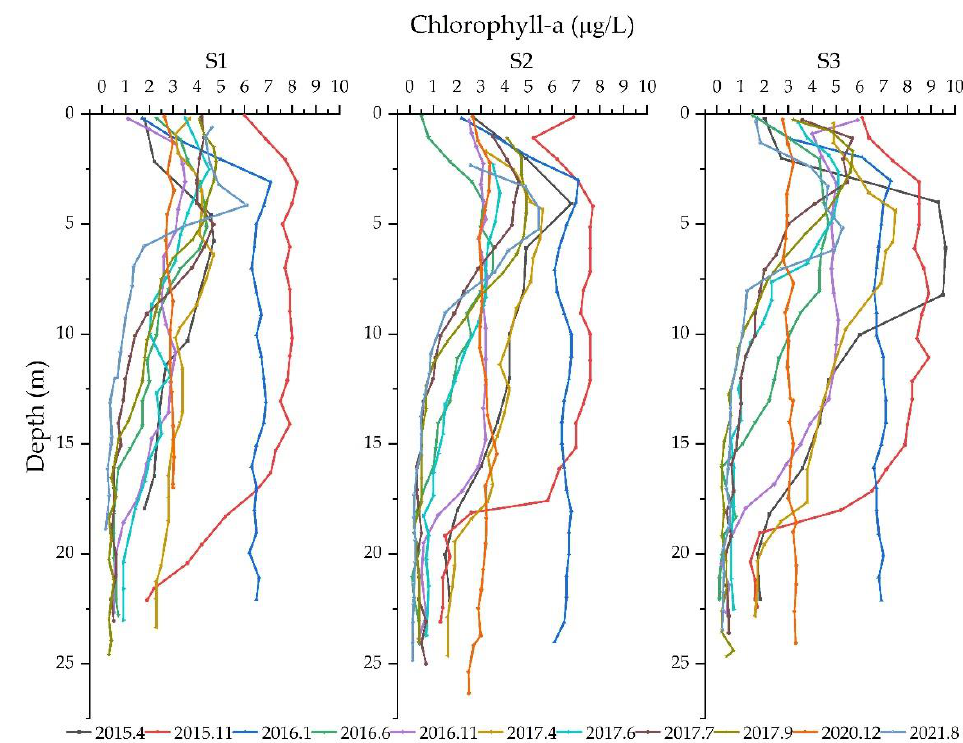
Figure 6. Vertical profile of Chlorophyll-a in Lake Yangzong.